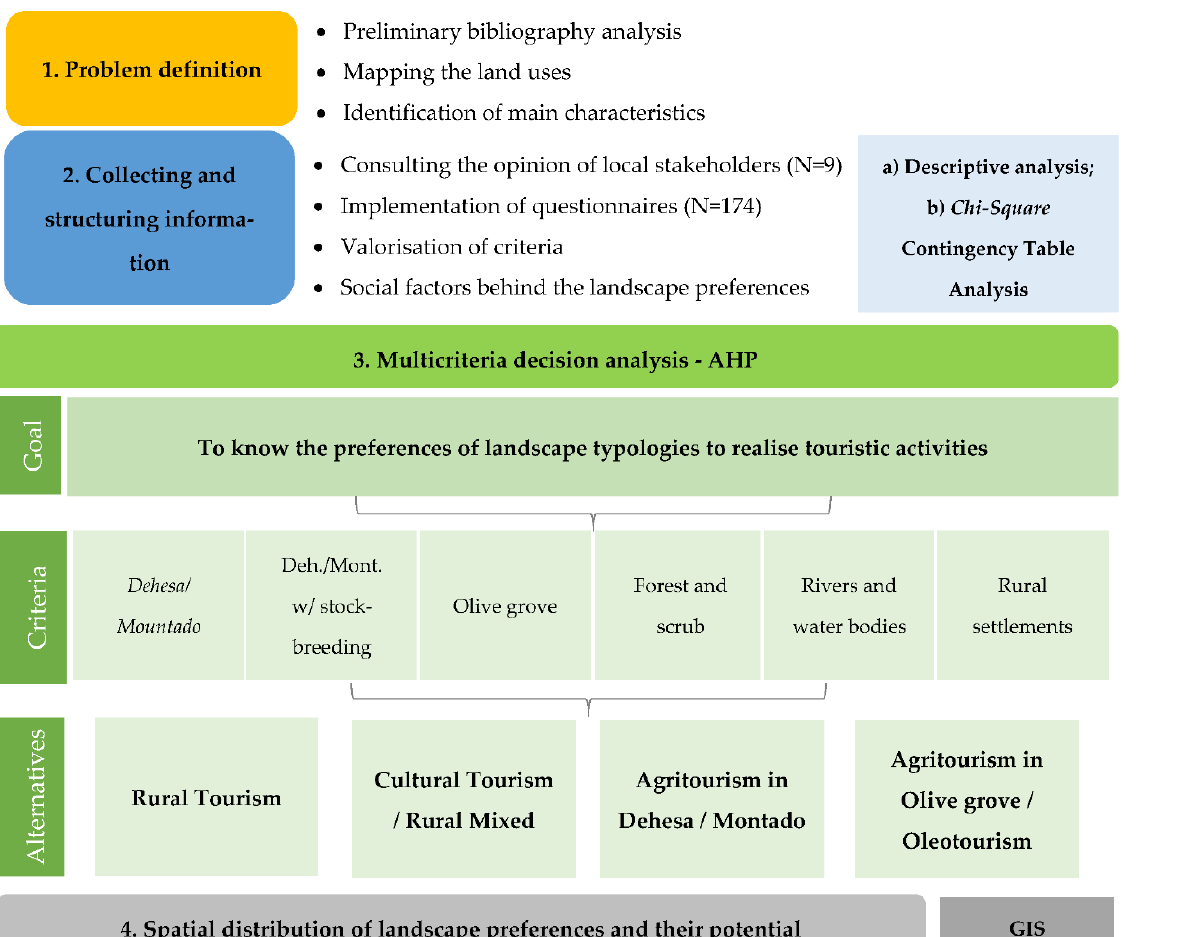
Figure 5. Methodological approach and AHP decision hierarchy.